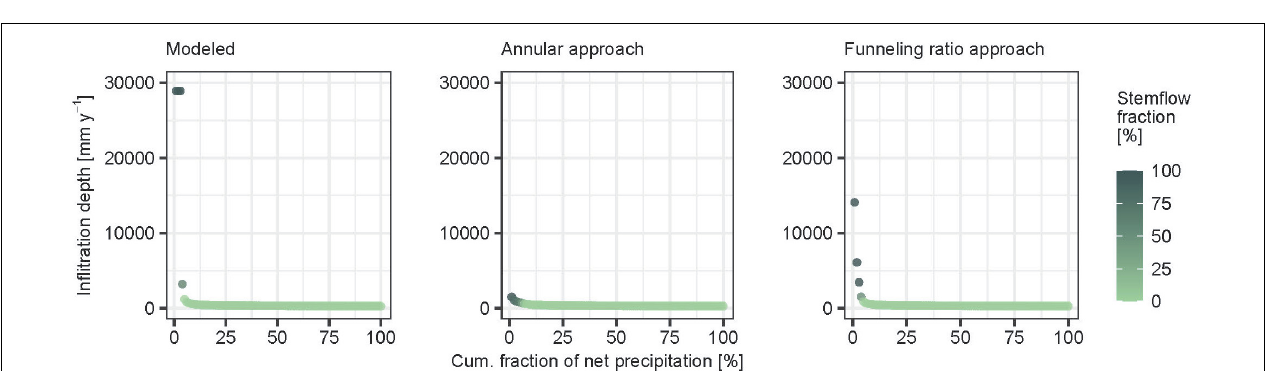
FIGURE 3 | Distribution of infiltration over the forest plot floor, for the model (Reynolds and Henderson, 1967) and the two funneling approaches (Herwitz, 1986; Tanaka et al., 1996). Shown is the cumulative fraction of net precipitation (sum of stemflow and throughfall) per area fractions of the study plot. Stemflow fractions are in color code.